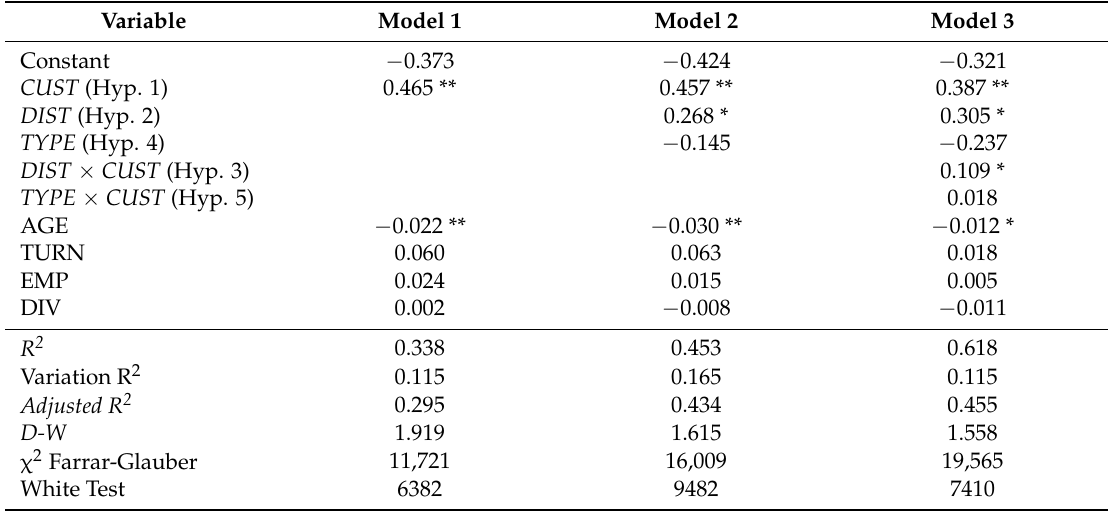
Table 3. Estimated model (Dependent variable CERT = percentage of certified